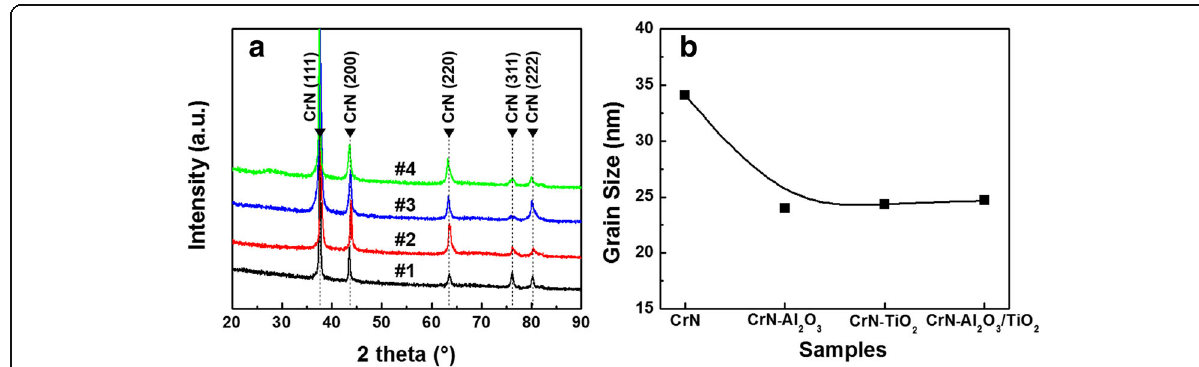
Fig. 2 a XRD patterns and b average grain size of the pure CrN and CrN hybrid coatings with various sealing layers (CrN-Al 2 O 3 , CrN-TiO 2 , and CrN-Al 2 O 3 /TiO 2